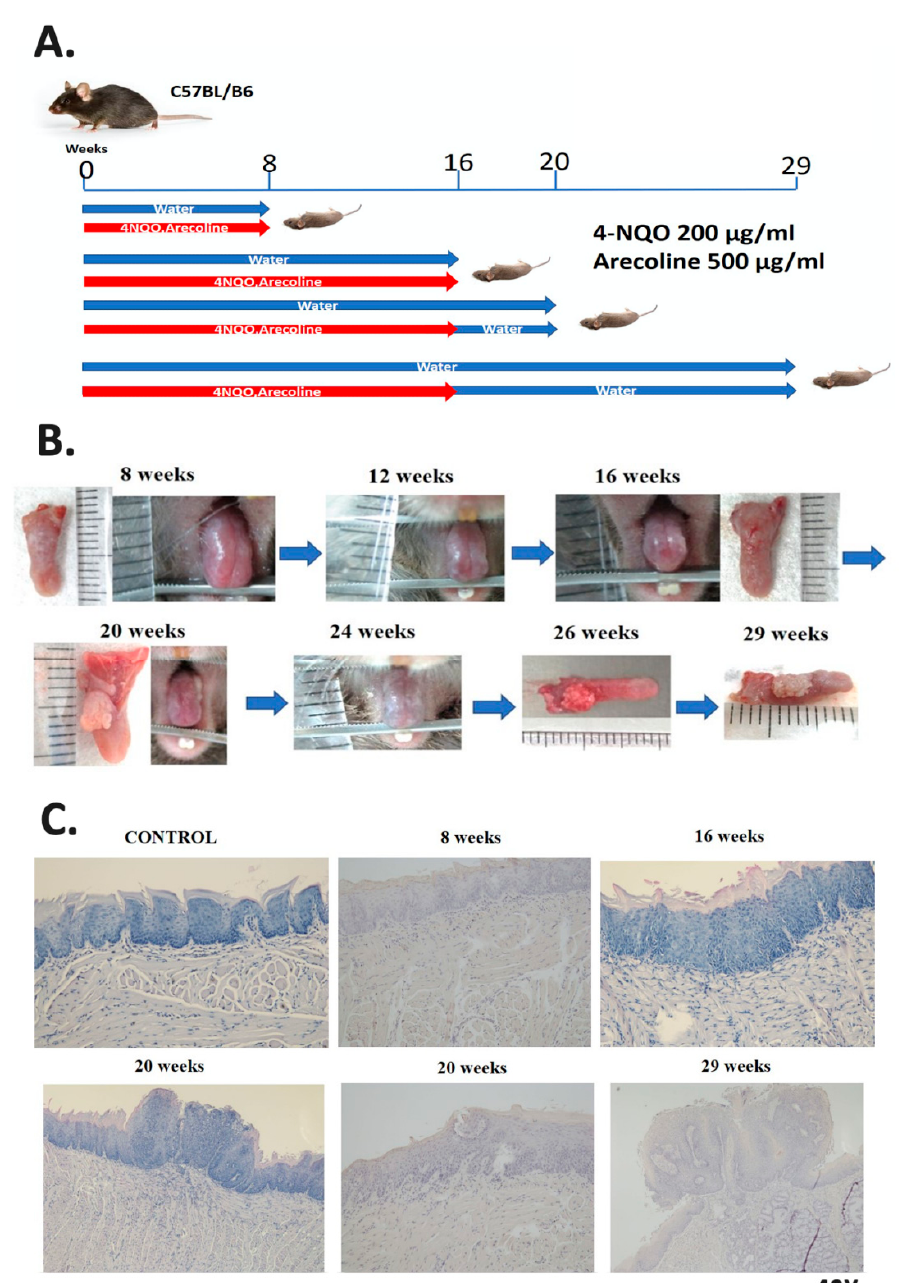
Figure 1. The carcinogen 4-nitroquinoline 1-oxide (4-NQO) (similar to carcinogens found in cigarettes) and arecoline (the carcinogen found in betel nut) were used to induce head and neck cell carcinogenesis in mice. ( A ) Four experimental and control groups were examined. Mice in the experimental group were fed drinking water containing 4-NQO and arecoline and then monitored until being sacrificed. ( B ) The progression of precancerous lesions on the tongue to cancer was monitored when mice were alive, and they were sacrificed at di ff erent time points. With the increasing duration of treatment in the experimental group, white lesions began to appear on the tongues of mice. Tumors were observed on the tongues of mice at week 16 and had become invasive carcinoma by week 29. ( C ) The tongues of mice in the control and experimental groups underwent hematoxylin and eosin staining for histopathological examination.